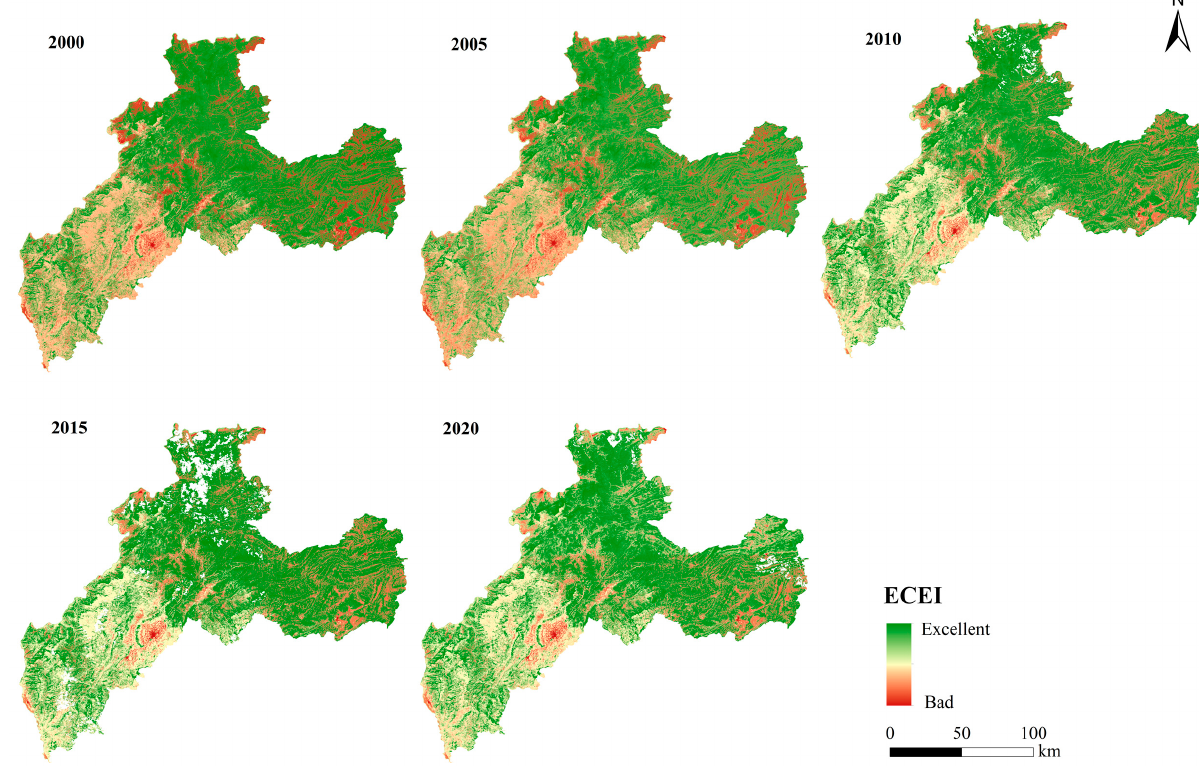
Figure 4. Spatial distribution of ECEI in Zhaotong from 2000 to 2020.